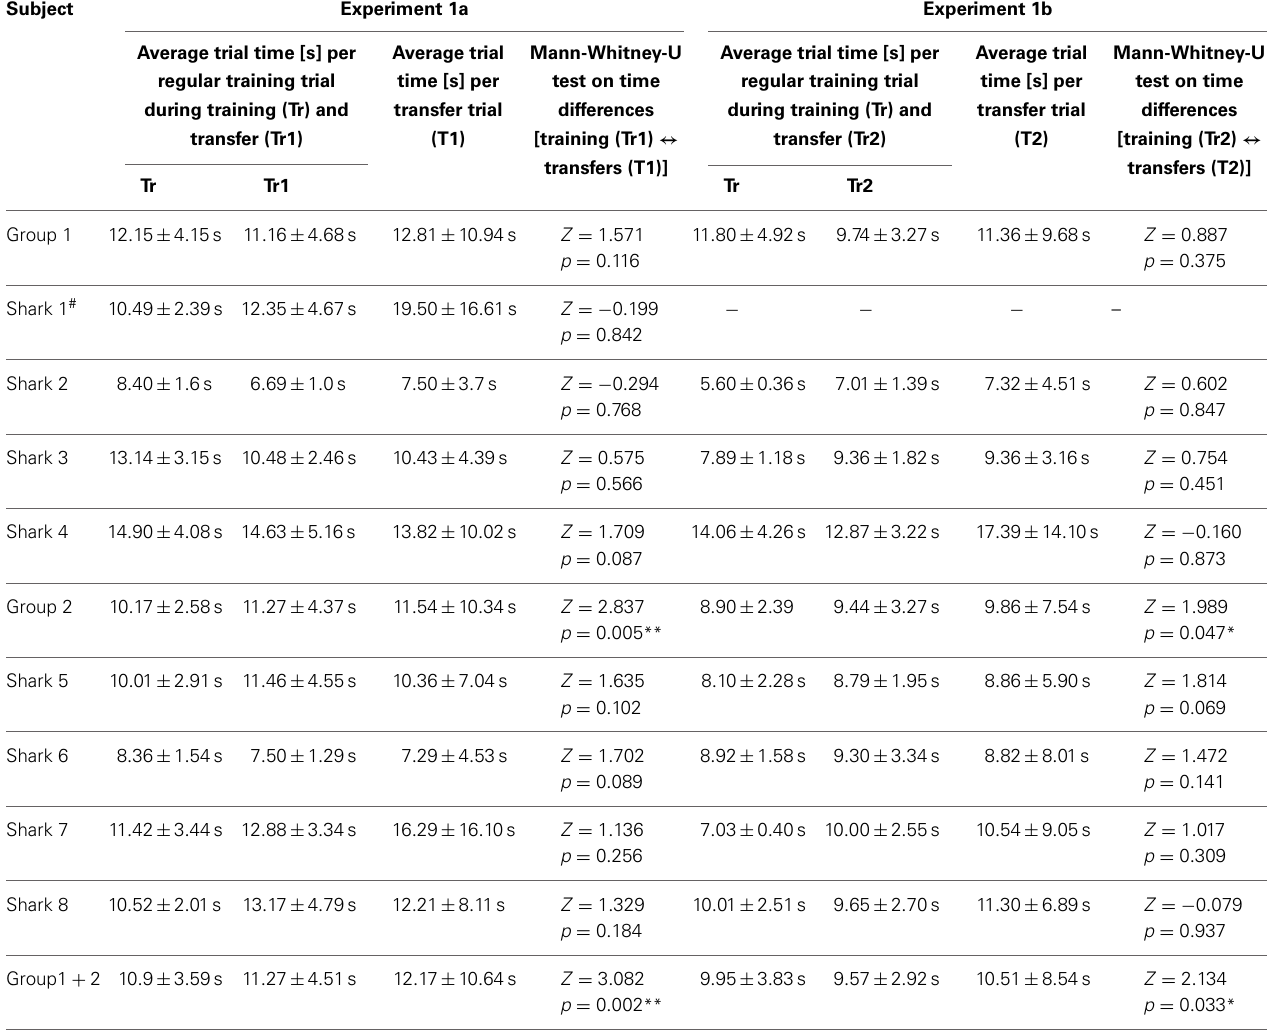
Table 1 | Part 2: Statistics on the average trial times [s] during regular training trials and transfer tests during Experiment 1: Kanizsa figures (Experiments 1a and 1b).